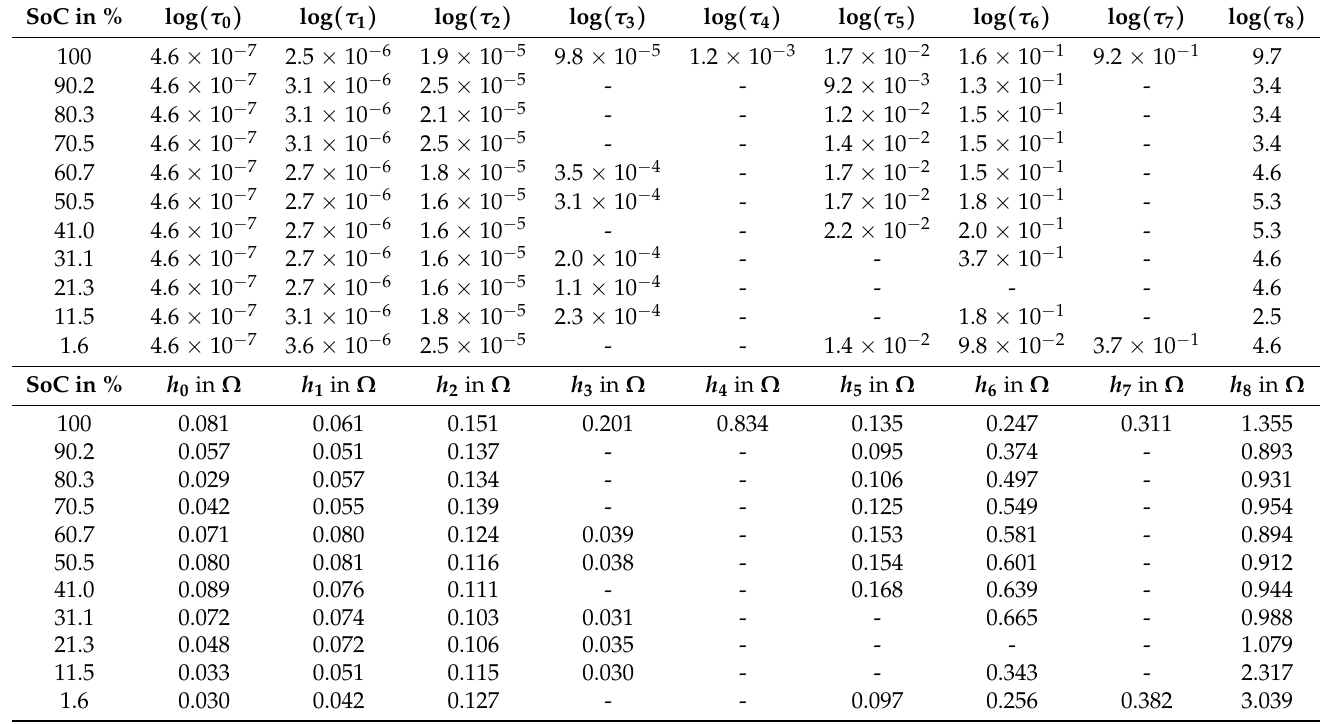
Table 2. Time constants and height of the characteristic peaks depending on the SoC at 303 K and a discharge current of 3 mA. SoC in